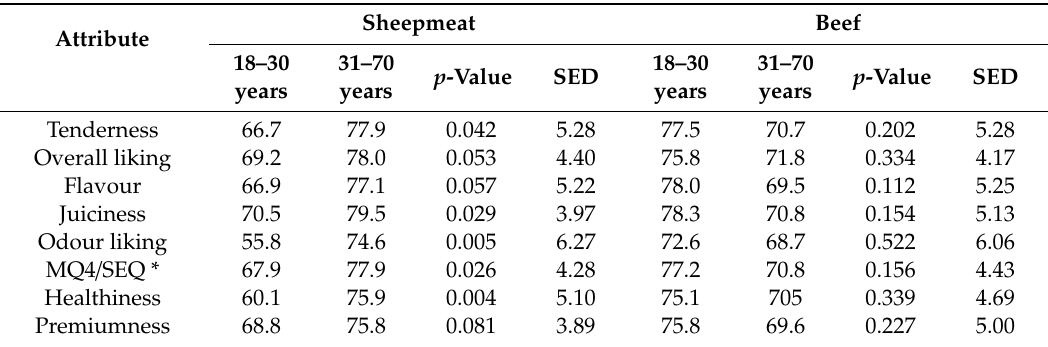
Table 3. E ff ect of consumer age category (18–30 or 31–70 years) on consumer scores for eating quality (tenderness, overall liking, flavour, juiciness, odour liking and MQ4 / SEQ), healthiness, and premiumness according to meat species (beef,